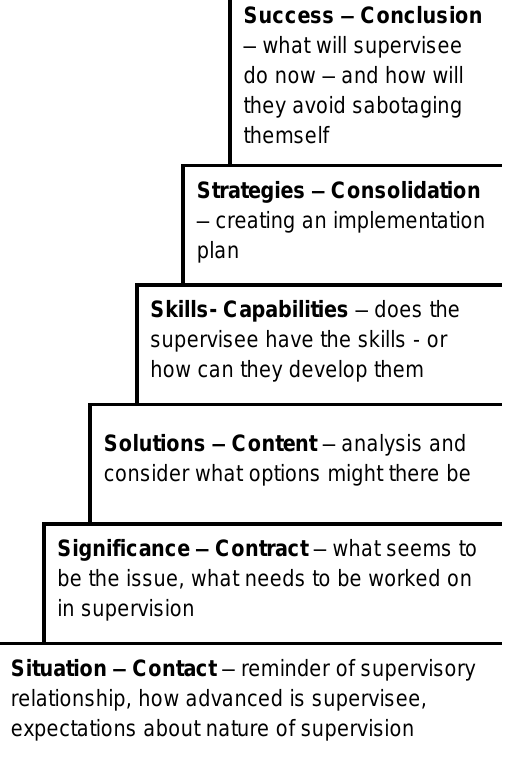
Figure 21: Stages of Supervision and Steps to Success Evans (1998) proposed a developmental-relational approach to supervision, on the basis of